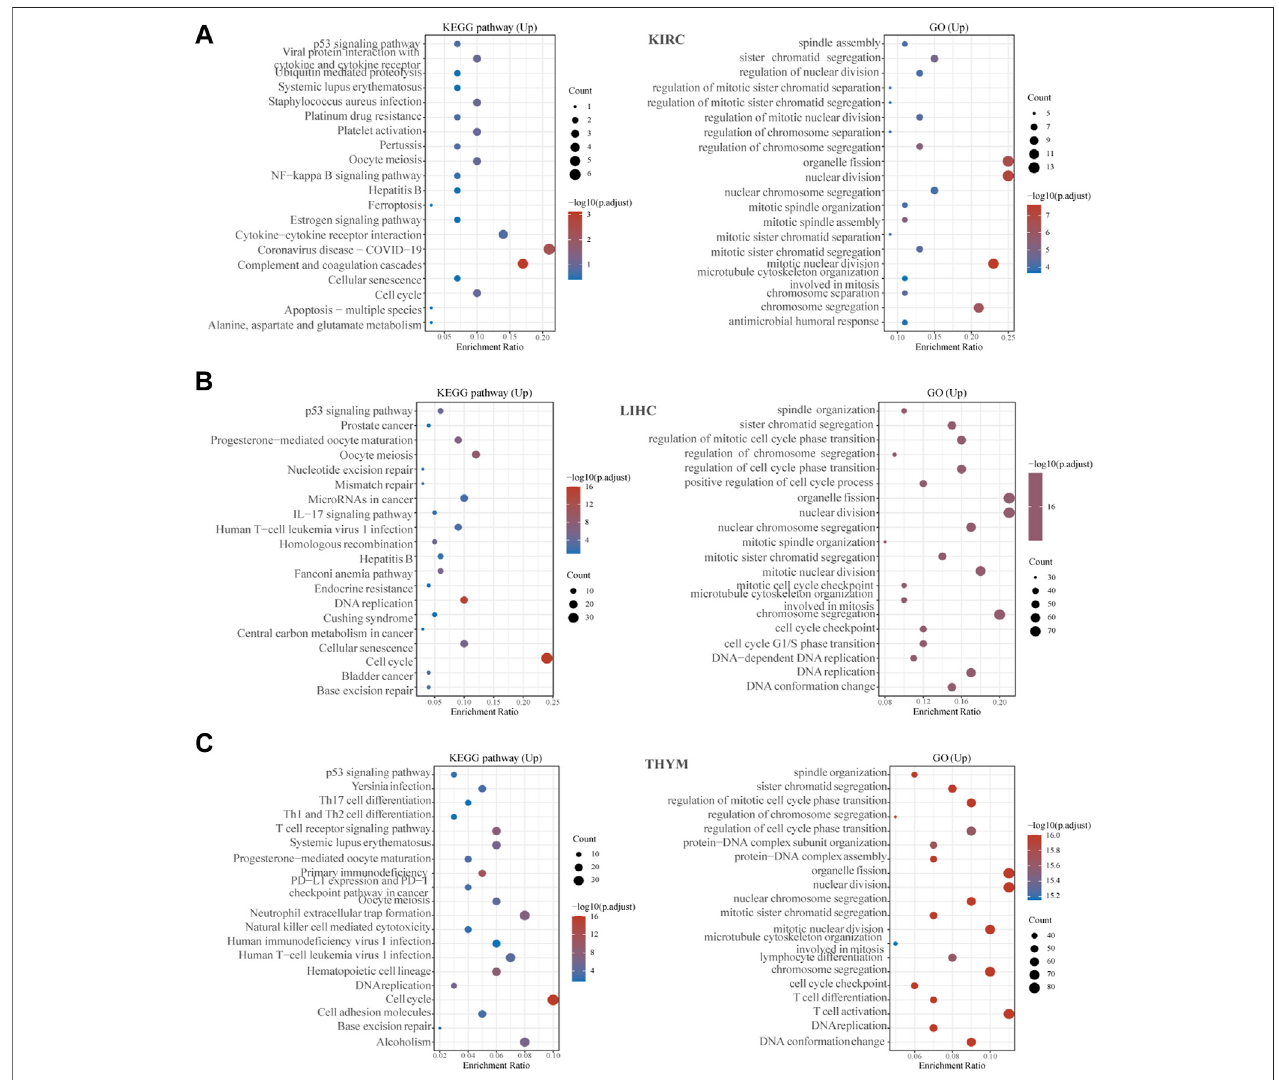
FIGURE 10 | Gene enrichment analysis of KIF2C in KIRC, LGG, and THYM. (A – C) Top 20 GO and KEGG pathway analysis in the speci fi ed tumor